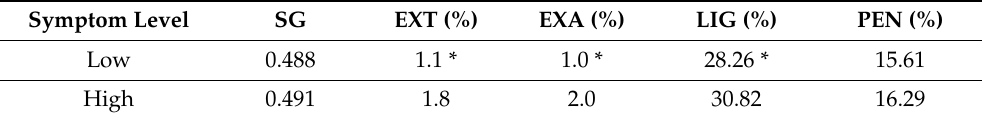
Table 3. Mean values of the woodchip specific gravity, chemistry, and pulping of Eucalyptus grandis × Eucalyptus urophylla trees under two growth conditions.